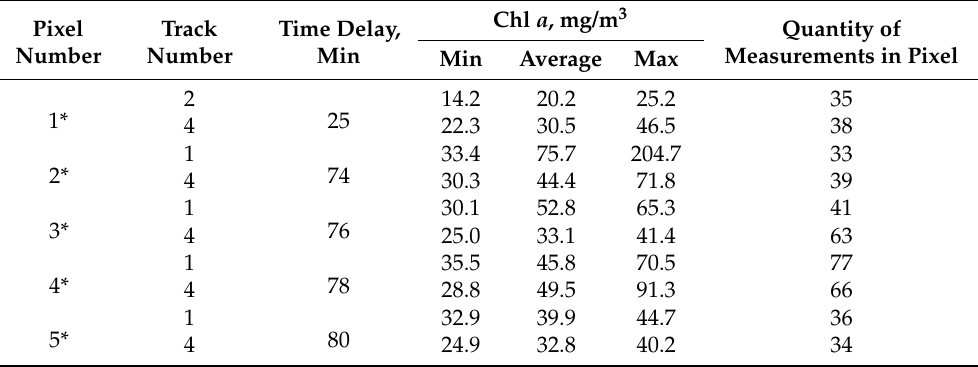
Table 3. Temporal variability of the concentration of Chl a in the Gorky Reservoir in pixels on Figure